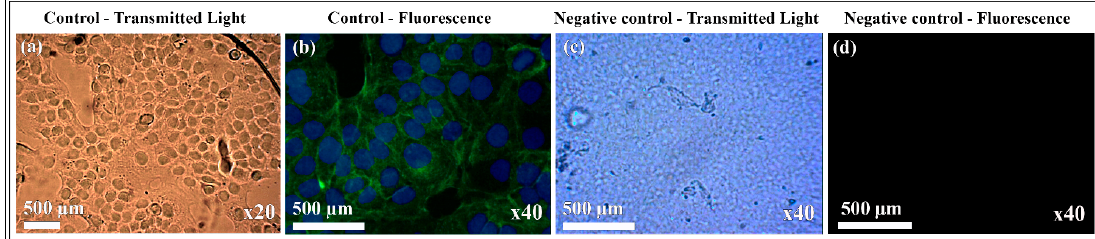
Figure 3. Cell adhesion of human keratinocyte HaCaT cells on glass coverslips (control) ( a , b ) and on calcium alginate films without carbon nanomaterials (negative control) ( c , d ) by optical microscopy in transmission light mode and fluorescence microscopy (DAPI and Phalloidin-FITC staining). The magnification of the utilized objective lens is indicated for each image. Cell adhesion on the glass coverslips is observed by either optical or fluorescence microscopy. Nevertheless, no cell adhesion is observed by neither optical nor fluorescence microscopy on calcium alginate.